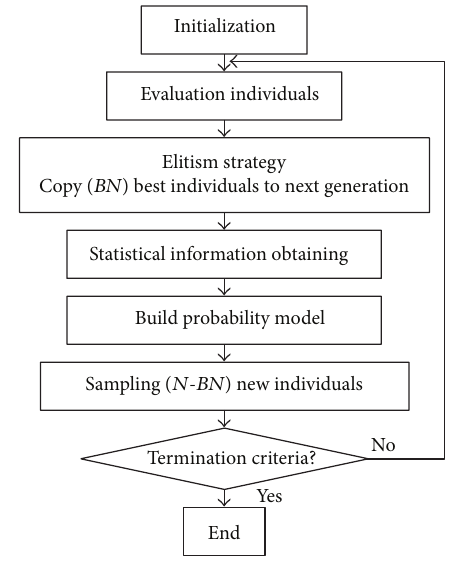
Figure 1: Flowchart of